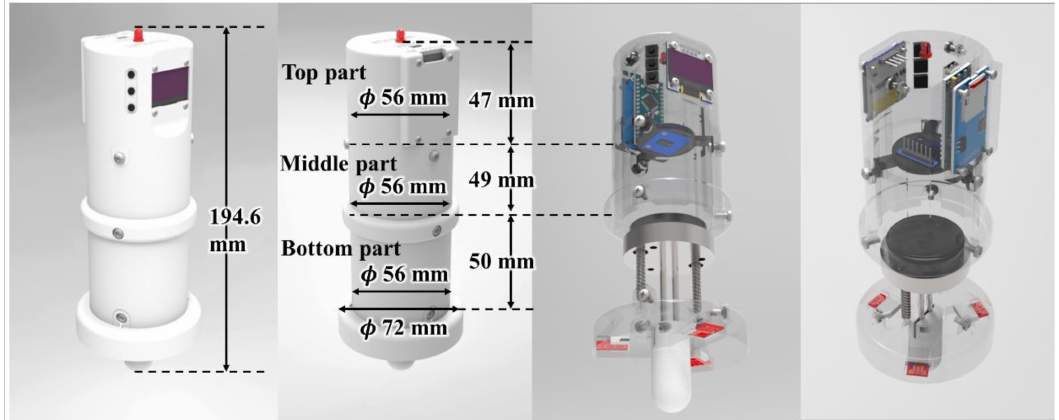
Figure 3. Appearance and internal structure rendering of portable fixed-stroke abdominal stiffness (PFAS)